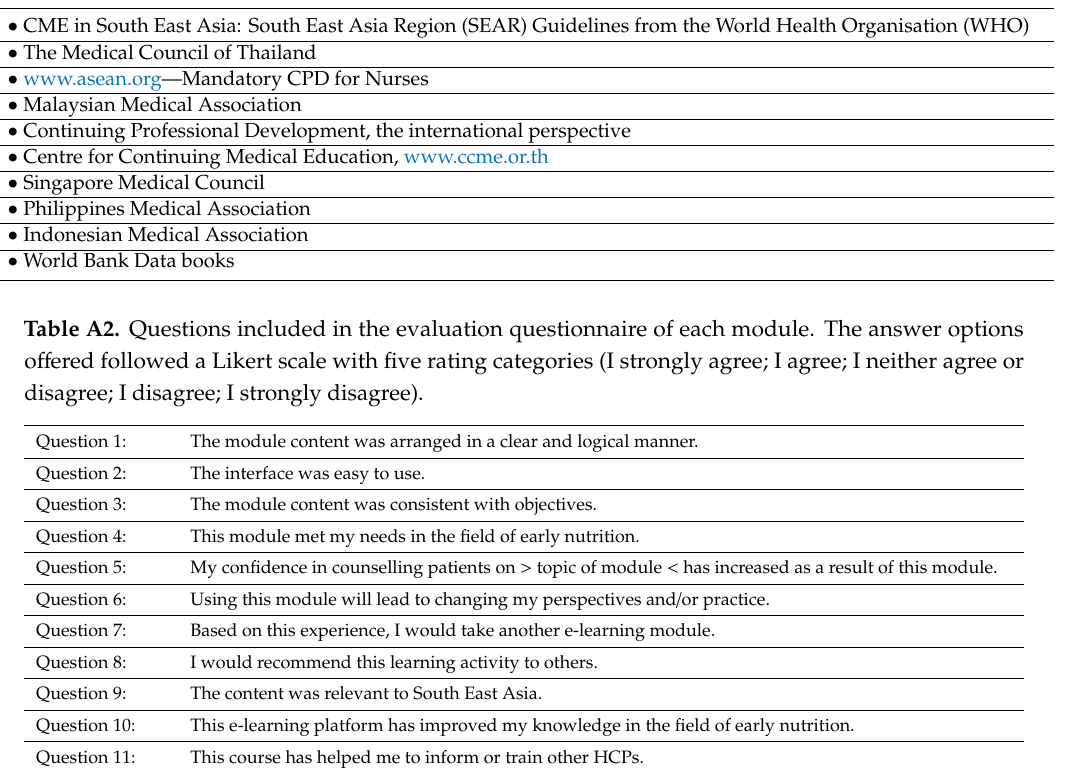
Table A1. List of documents and websites analysed in the desktop research to study and understand the present landscape of CME / CPD systems in Thailand and Malaysia, and in the SEA region. Using the Google search engine, the terminologies searched comprised: CME / CPD in Southeast Asia, Medical Association of Thailand, Medical Council of Thailand, Medical Association of Malaysia, WHO Guidelines, ASEAN Recommendations.